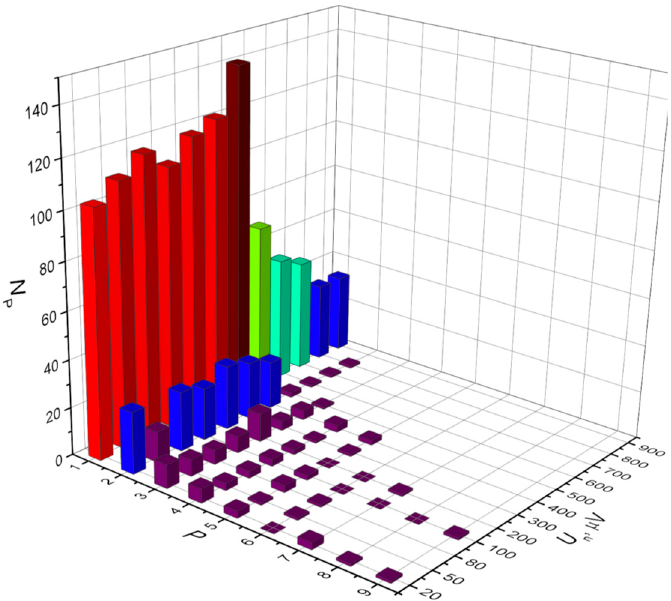
Figure 15. Dependence of solution number N P for various values of P on noise level U n ( η th = 90%).